Question: What type of chart is this?
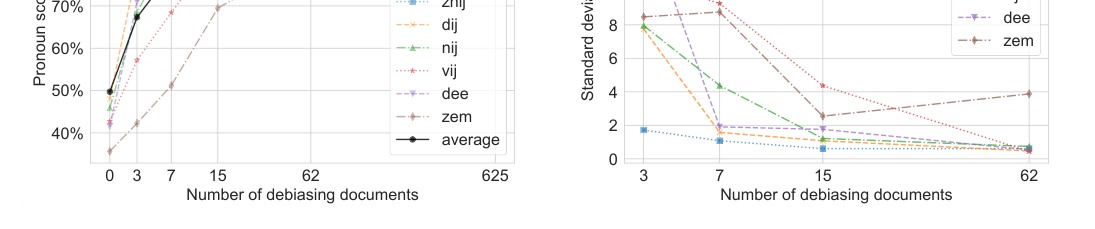
Answer: line